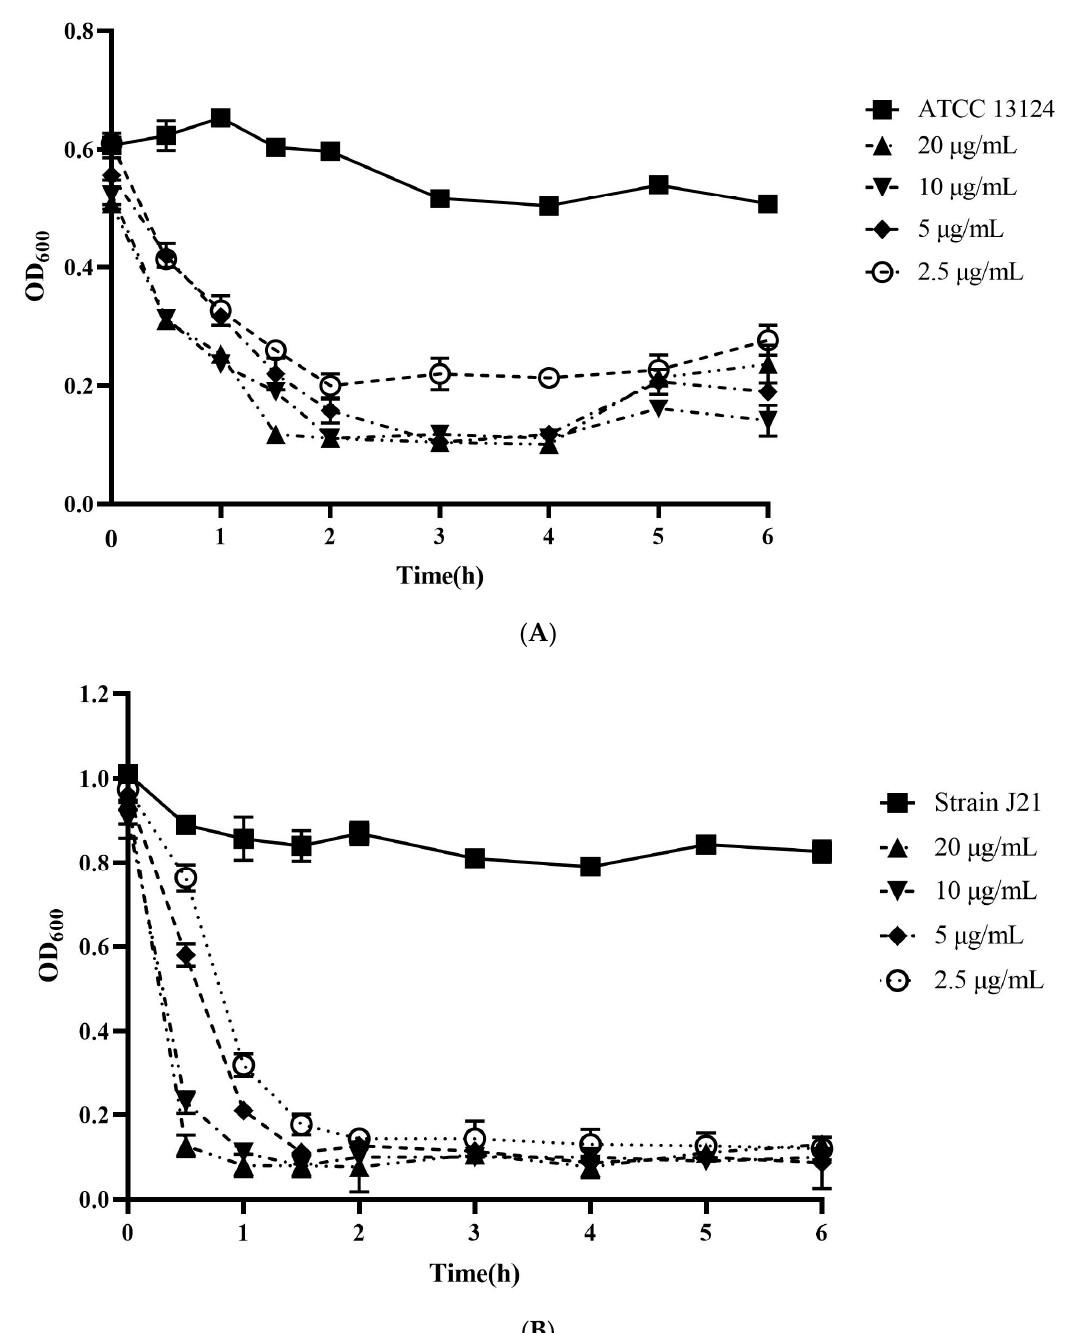
Figure 1. Time-kill assay of C. perfringens ATCC 13124 ( A ) and J21 ( B ) cultures treated with purified LysCP28. Optical density was measured periodically. C. perfringens ATCC 13124 and J21 without treatment were used as controls. Each test was assayed in